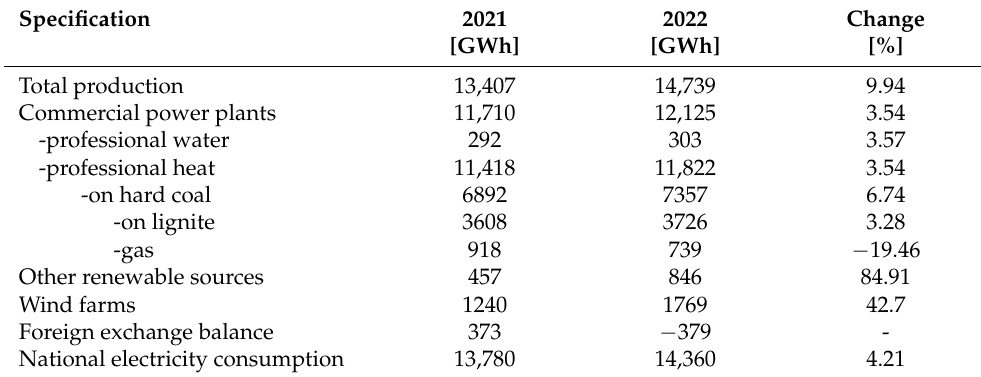
Table 3. Electricity production in April 2021–2022.